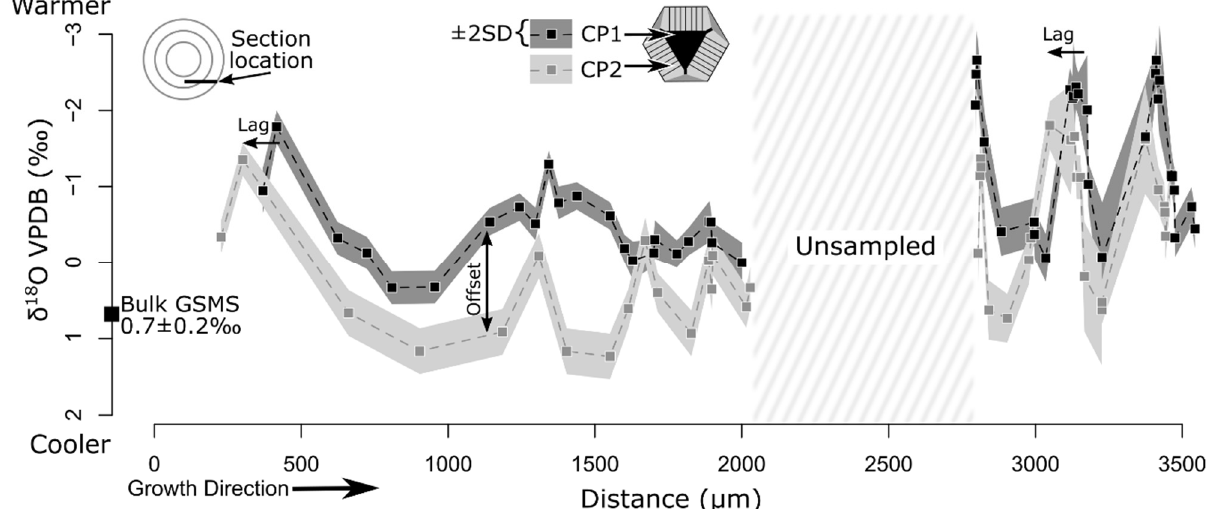
Figure 3. Variation in δ 18 O across the belemnite rostrum. CP1 generally has lower δ 18 O compared to adjacent CP2 (mean offset of 0.8‰). At several points, δ 18 O of CP2 is lower than that of nearby CP1, most notably near 3250 µm. This crossover highlights the lag between sinusoids in CP1 and CP2. Growth banding is more closely spaced toward the right of the sampling transect because of the geometry of growth rings related to the cutting plane (Figure 1C and inset in top left corner). A single bulk value using conventional acid digestion gas-source mass spectrometry (GSMS) was sampled in a trench parallel to the SIMS transect for method comparison.